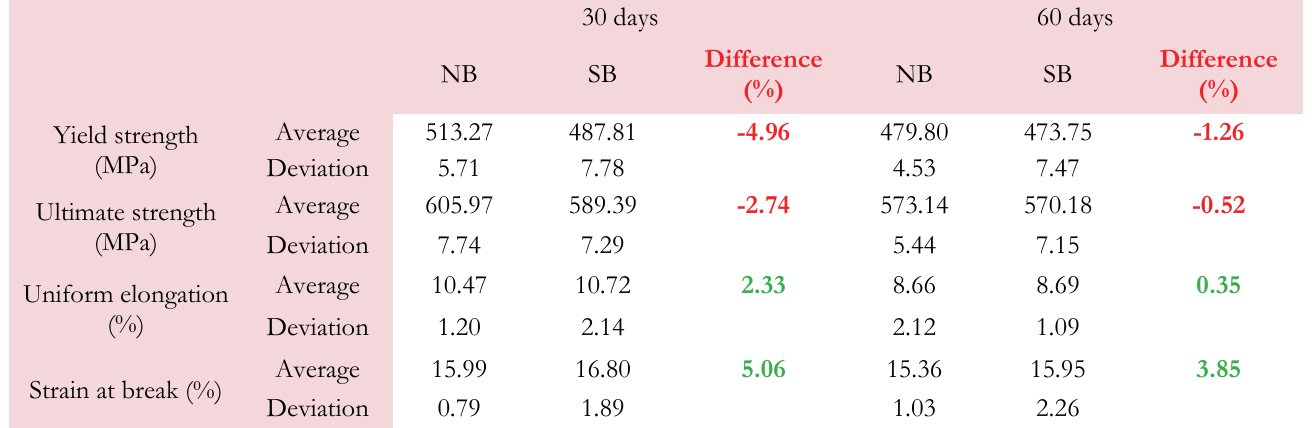
Table 7: Tensile results values and